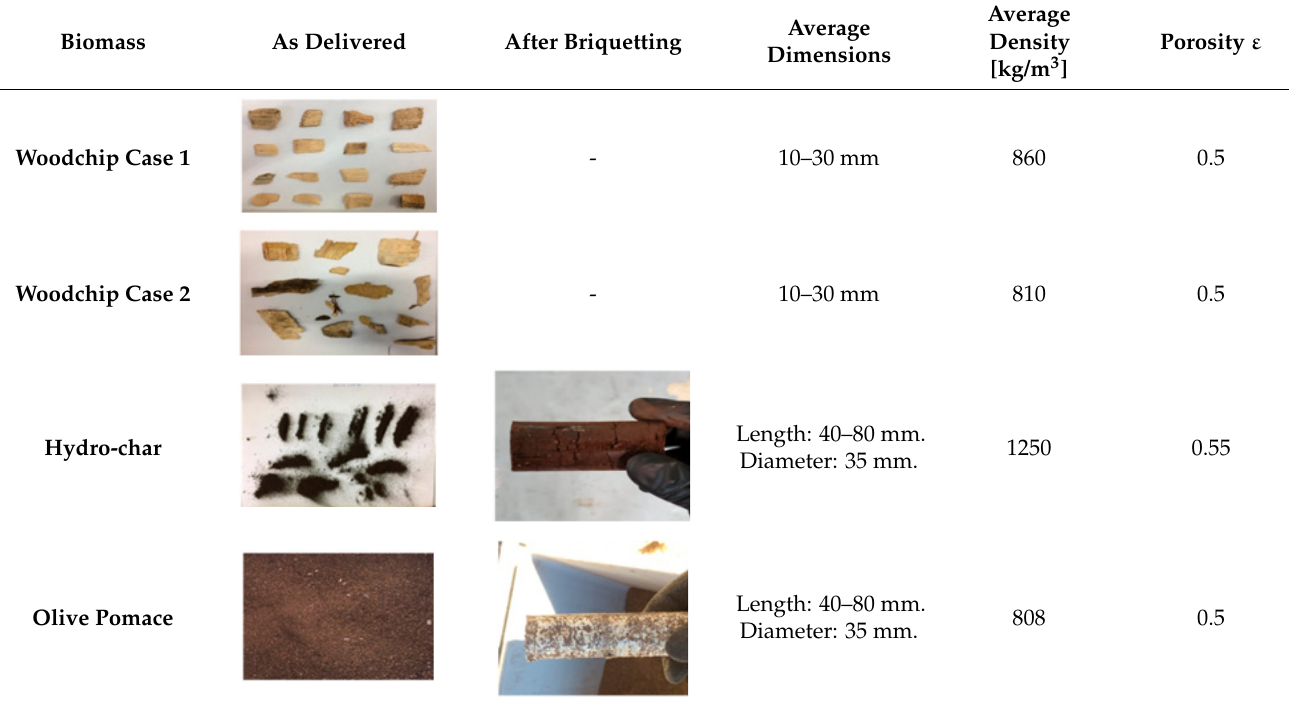
Table 3. Tested biomasses before and after briquetting treatment and assumed degree of porosity in the reactor. Biomass As Delivered After Briquetting